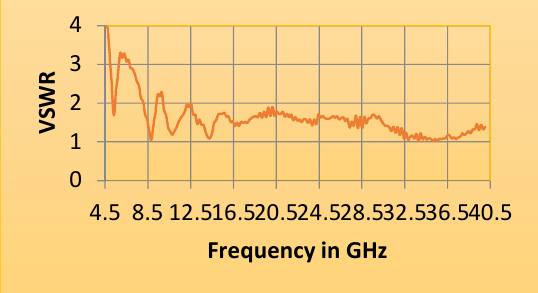
FIG. 12. S 11 VERSUS FREQUENCY